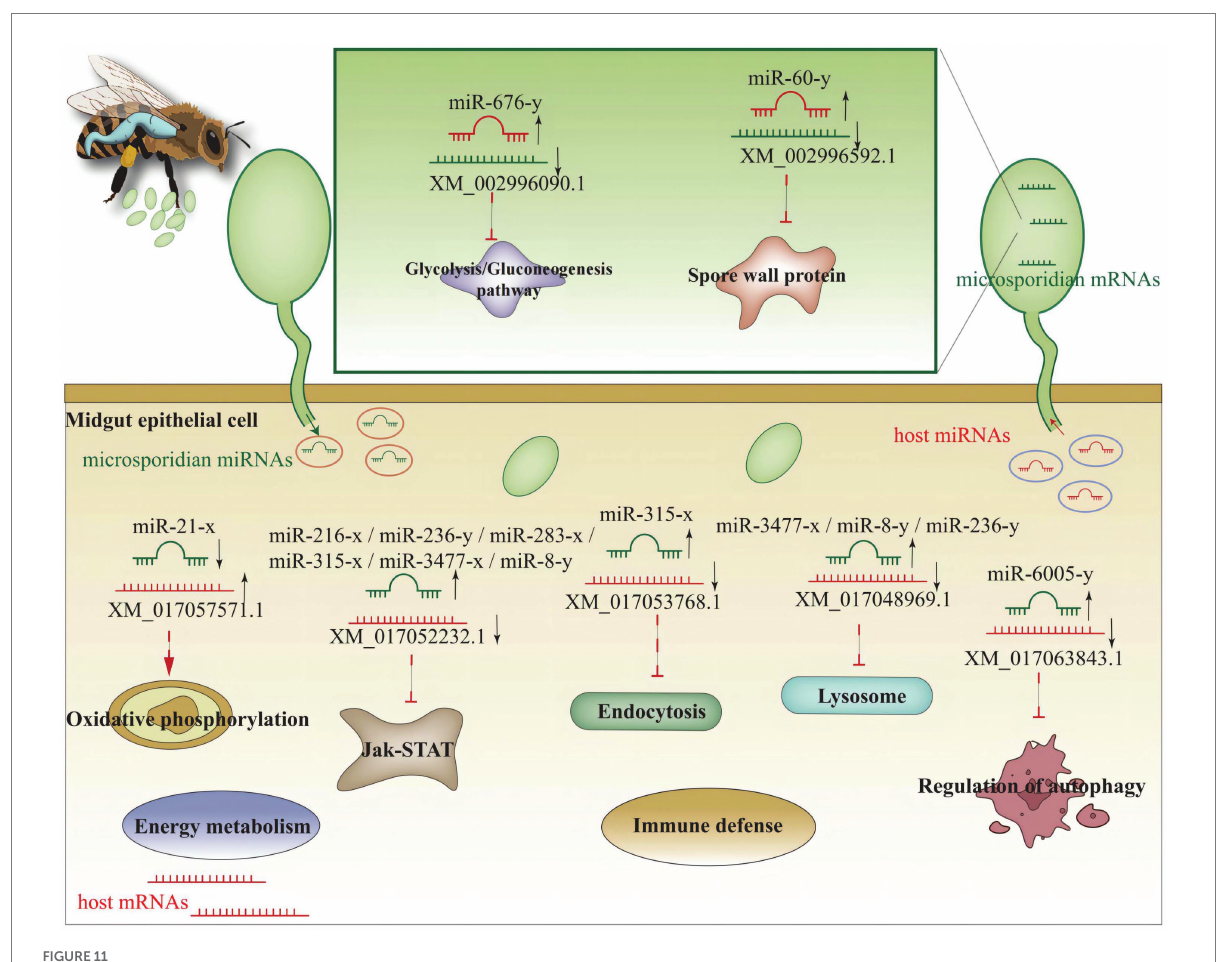
FIGURE 11 miRNA-mediated cross-kingdom regulation between A. c. cerana and N.